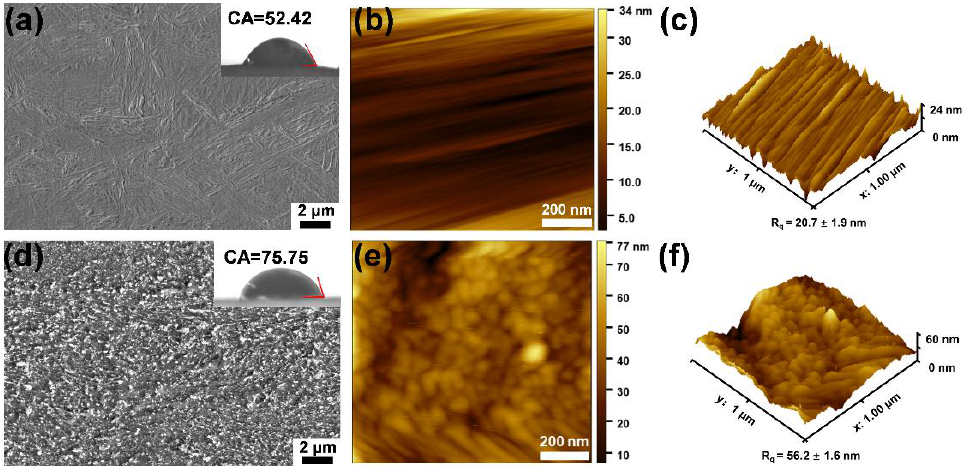
Figure 3. SEM images of basal membrane ( a ) and ZIF − 8/PDA/PAN composite membrane ( d ), and the illustrations of their CA, respectively. The 2D and 3D AFM images of basal membrane ( b , c ) and ZIF − 8/PDA/PAN composite membrane ( e , f ).